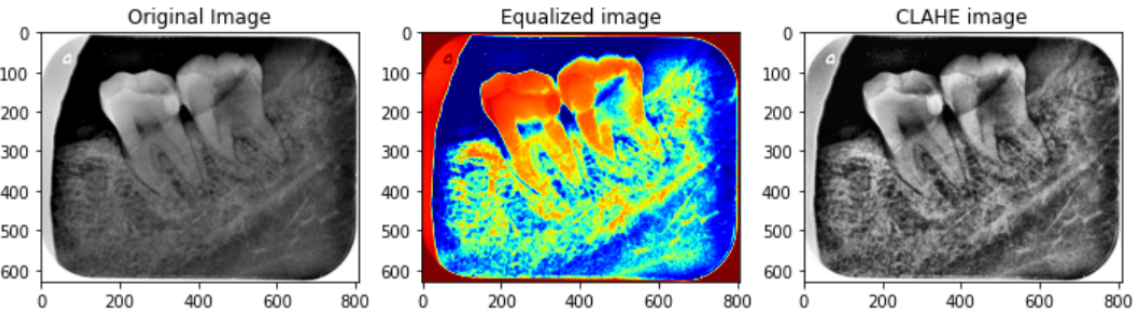
Figure 7. Preprocessed image sample using CLAHE. The left image is the original image, the middle image is color equalized image while the right image is the final CLAHE image.